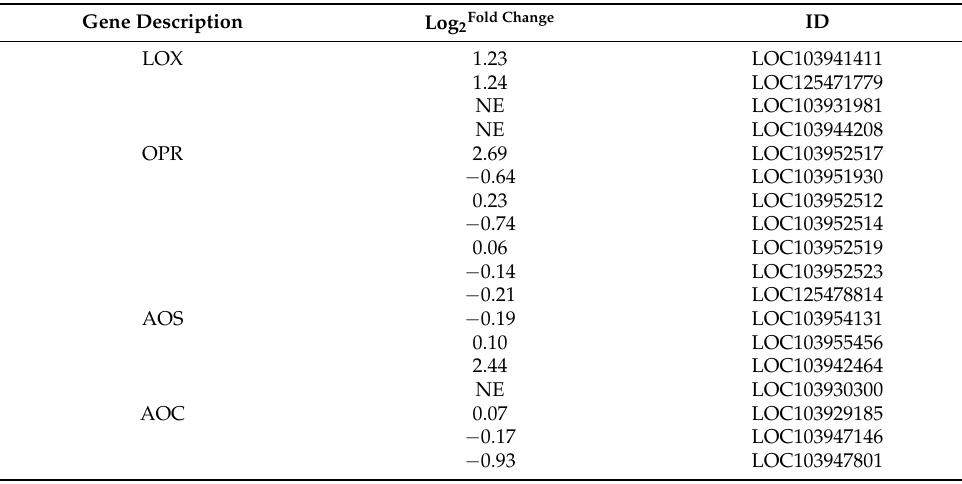
Table 4. Expression levels of JA synthesis genes. NE refer to not